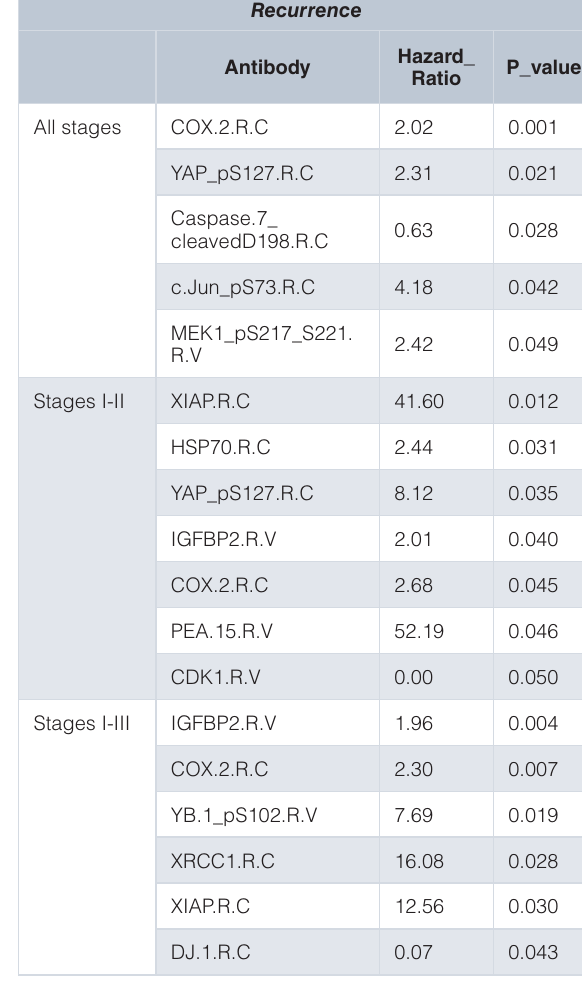
regression analysis identifying proteins associated with recurrence. Only proteins with a significant p-value (<0.05) were